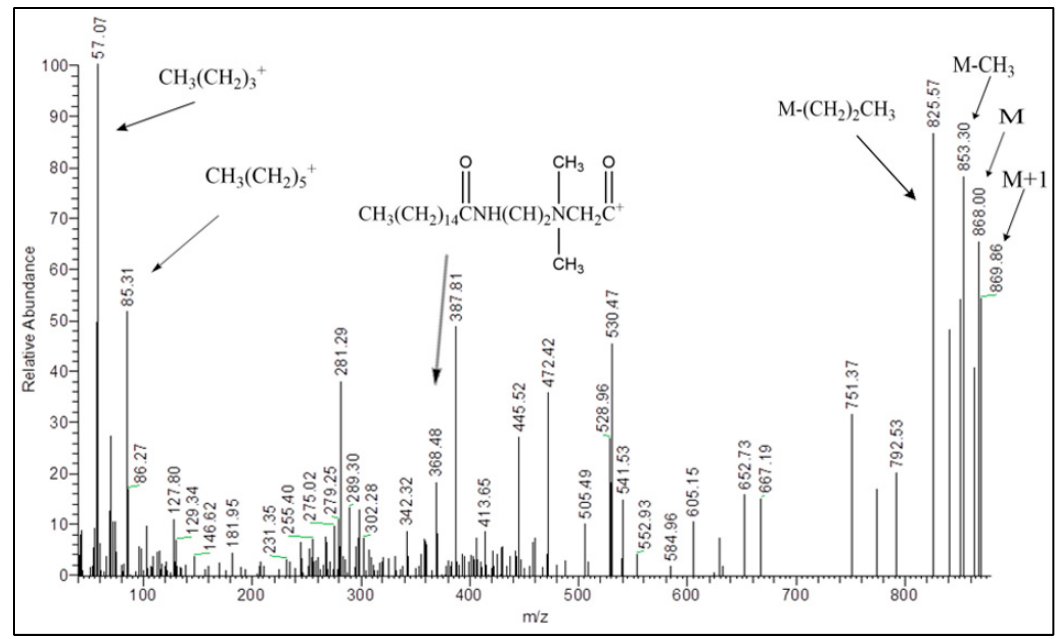
Figure 3. Mass spectrum for CGSES16.